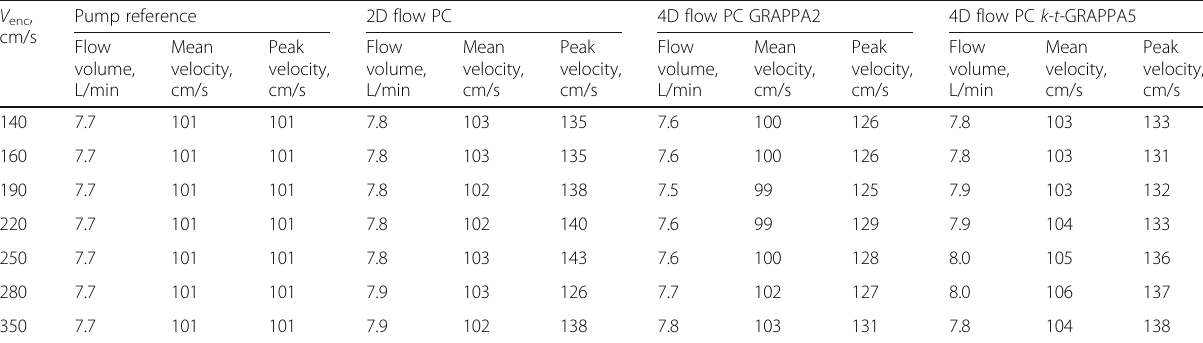
Table 3 Distribution of measurements of the flow volumes, mean velocity, and peak velocity for 2D flow and two 4D phase- contrast sequences (GRAPPA2 and k-t- GRAPPA5) with different encoded velocities ( V enc